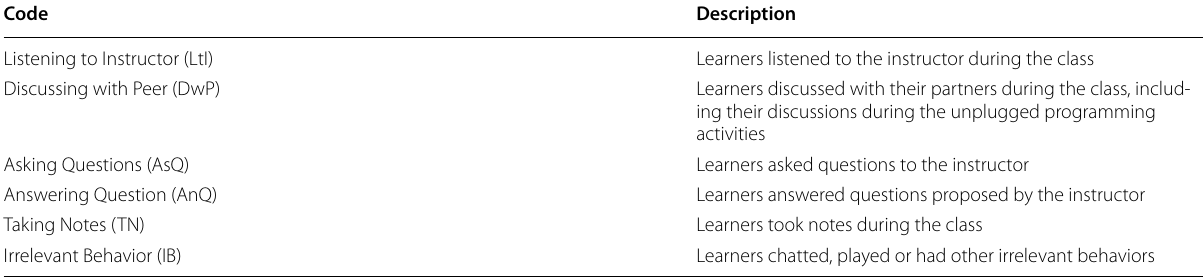
Table 1 Coding framework for classroom behaviors